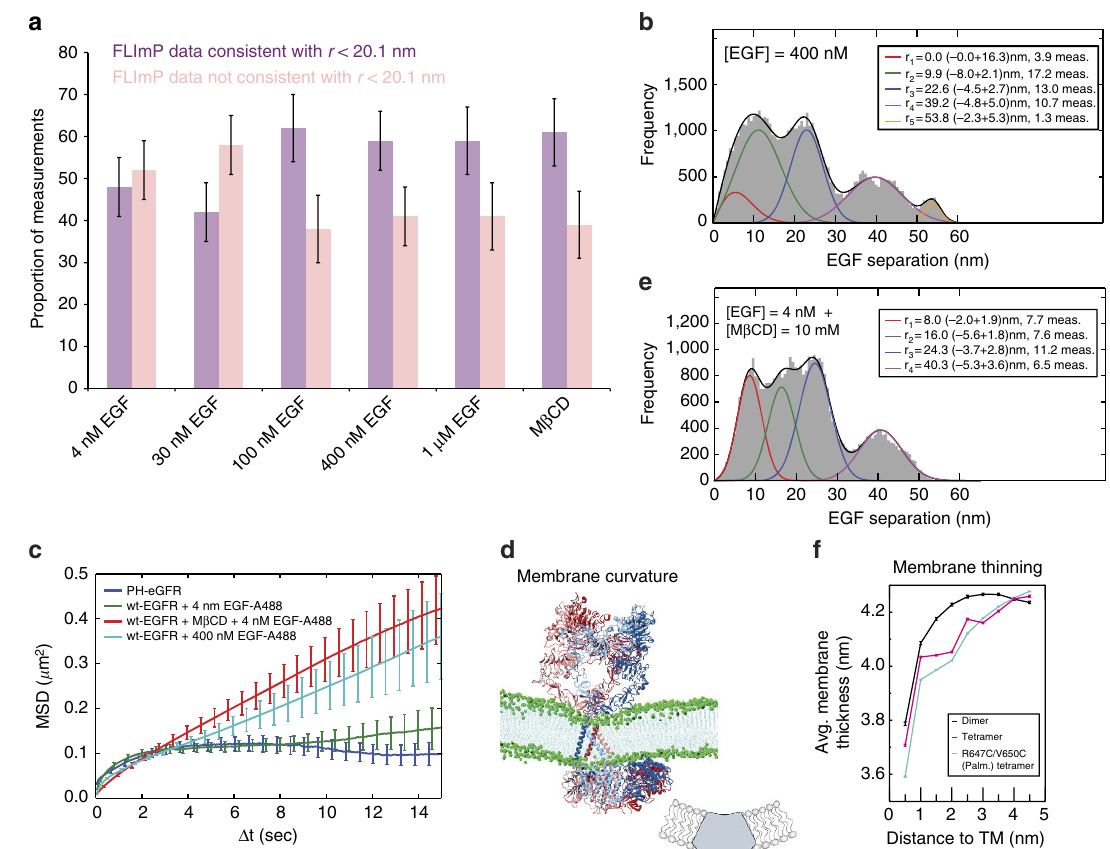
Figure 6 | Membrane bending and EGFR oligomerization. ( a ) Percentage of separations whose 69% confidence intervals overlap with the dimer/tetramer range ( r o 20.1nm) or do not ( r 4 20.1nm), estimated by the ratio of the integral area of interest (purple or salmon in FLImP distributions, Supplementary Fig. 7) to the integral area of the distribution. ( b ) FLImP distribution (grey) of pairwise separations of fluorophore-conjugated EGF on CHO cells expressing B 10 5 copies of wild-type EGFR treated with 400nM EGF (46 measurements). The distribution is fitted (black line) with a sum of five Rician peaks (colour lines). Best-fit positions and error bars shown in the inset. ( c ) (green) MSD plot from single-particle tracks of wild-type EGFR complexes on live CHO cells at 37 (cid:2) C labelled with Alexa 488-conjugated EGF; (dark blue) MSD plot from single-particle tracks of PIP 2 labelled with a PLC d 1-Pleckstrin homology (PH) domain (PH-eGFP) fusion construct which specifically binds PiP 2 (ref. 75), transfected on CHO cells expressing wild-type EGFR. MSD plots include data from B 4 10 3 tracks and three biological repeats. Bootstrap-estimated errors (vertical line) are shown. Linear MSD plots suggest Brownian motion; concave-down MSD plots suggest confinement at the plasma membrane 76 . ( d ) The negative curvature of the membrane local to an EGFR tetramer in simulation. The cartoon illustrates the membrane-bending effect of the N-terminal dimers of EGFR transmembrane helices as a hydrophobic wedge. ( e ) FLImP distribution (grey) of pairwise separations of fluorophore-conjugated EGF on the surface of CHO cells expressing B 10 5 copies of wild-type EGFR pre-treated with 10mM M b CD, exposed to 4nM EGF (33 measurements). Best-fit positions and error bars are shown in the inset. ( f ) Membrane thickness ( Y -axis) as a function of distance to the transmembrane helices ( X -axis) in simulations of the wild-type active dimer and tetramer, and the palmitoylated R647C/V650C tetramer. The membrane thickness is indicated by the average separation between the two sheets of phosphorus atoms of the two lipid layers. The wild-type tetramer (red line) exhibited a more pronounced membrane-thinning effect. The data are plotted as averages and standard error